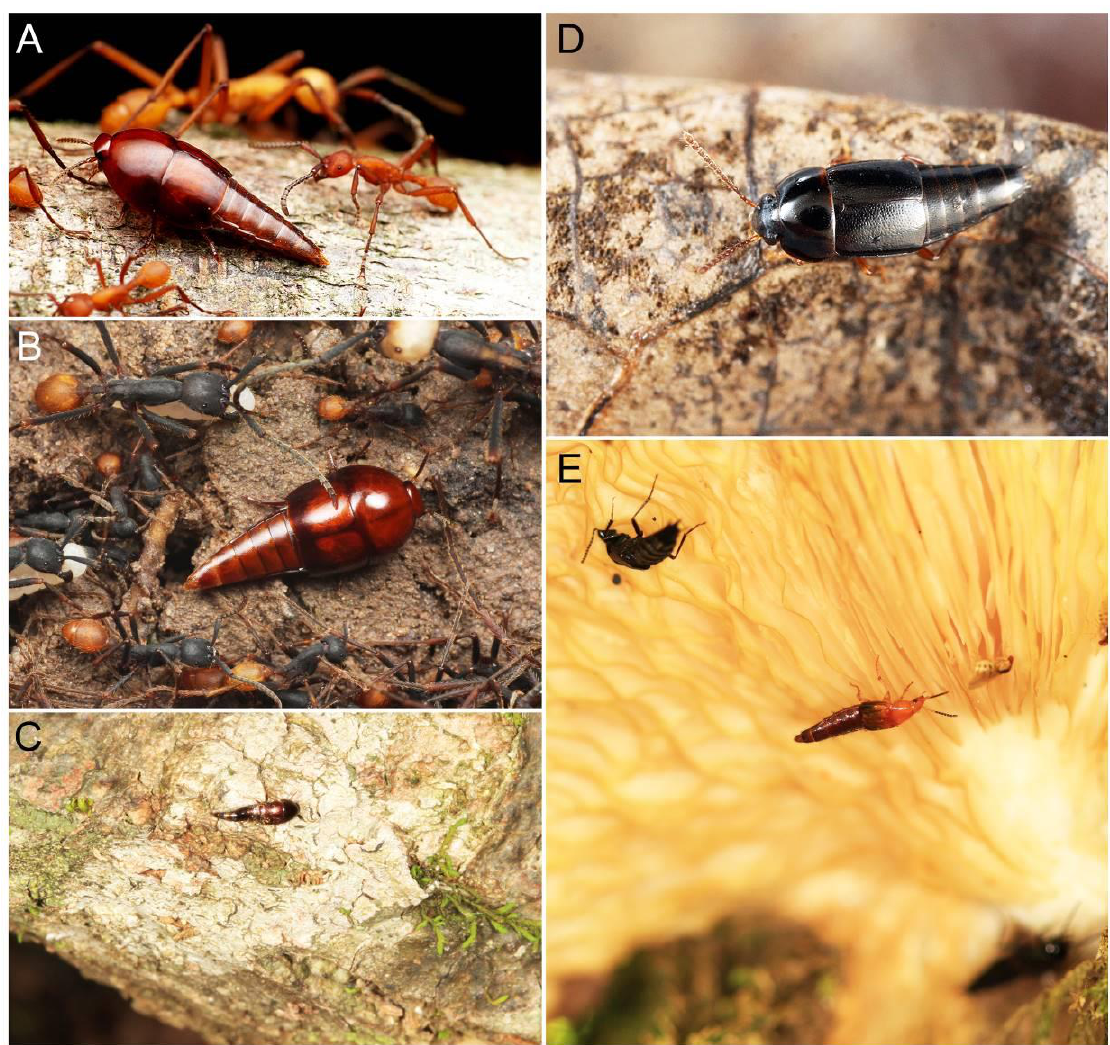
Figure 1. Photos of Tachyporinae adults in their corresponding microhabitats. ( A ) Vatesus sp. 1 (Vatesini) associated with the army ant species Eciton hamatum (Fabricius) in French Guiana. ( B ) Vatesus sp. 2 (Vatesini) associated with the army ant species Eciton burchellii (Westwood) in Peru. ( C ) Sepedophilus sp. belonging to S . crassus species group (Tachyporini) in Kumamoto Pref., Japan. ( D ) Tachinus ( Tachinoderus ) sp. (Tachyporini, now Tachinusini) in Shimane Pref., Japan. ( E ) Lordithon ( Lordithon ) bicolor (Gravenhorst) (Mycetoporini, now Mycetoporinae) in Kumamoto Pref., Japan. Photo credits: Taku Shimada ( A , B ) both used with permission) and Masakazu Hayashi ( D ), used with